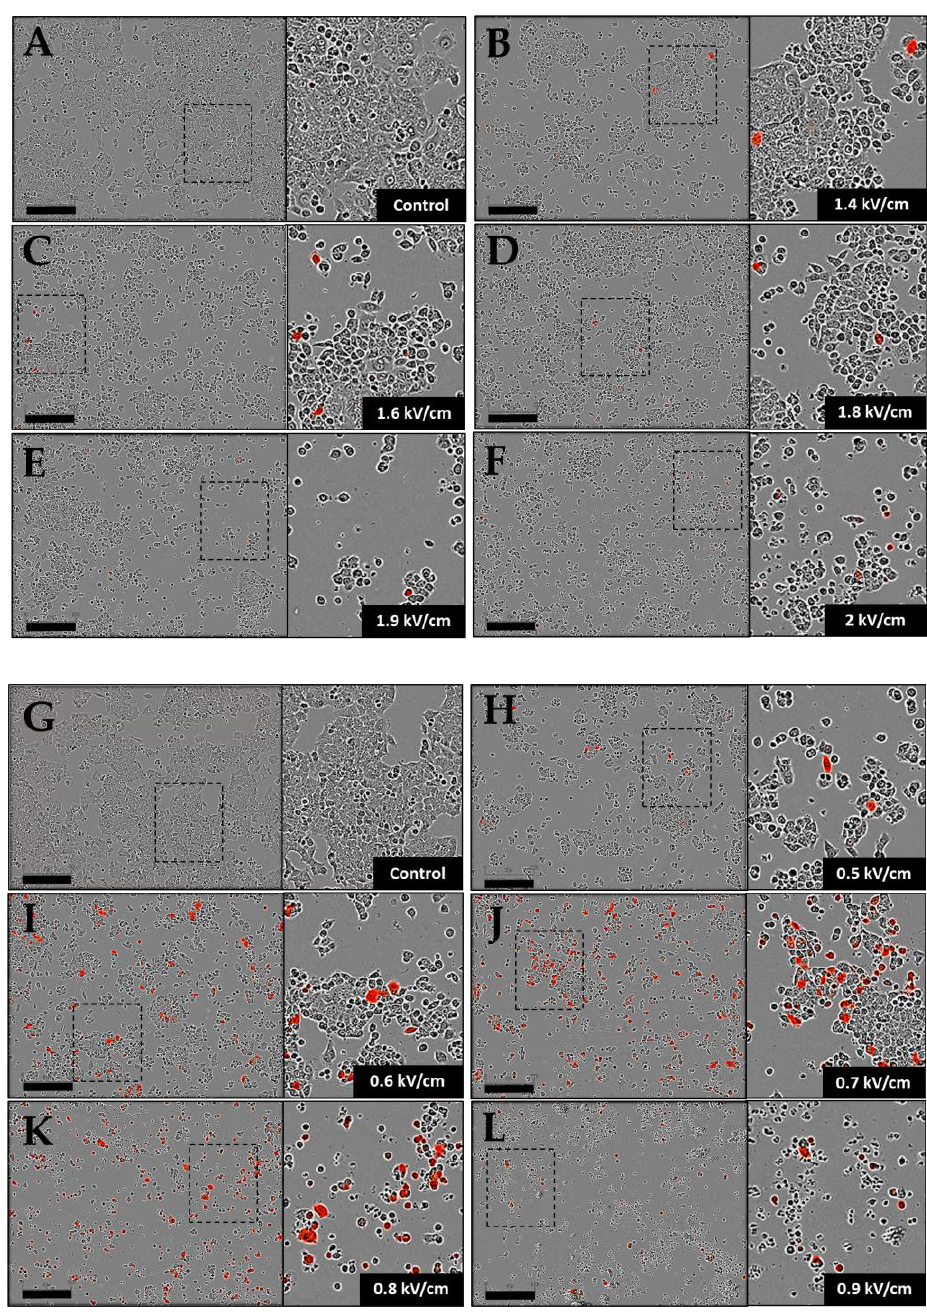
Figure 3. Representative bright field and fluorescent micrographs of HCT-116 cells, observed 24 h after pulsation. Cells were incubated with 40 µg/mL plasmid-encoding tdTomato, and ECT pulse parameters (8 pulses of 100 µs at 1 Hz with variables field intensity (1.4 to 2 kV/cm)) and GET pulse parameters (10 pulses of 5 ms at 1 Hz with variables field intensity (0.5 to 0.9 kV/cm)) were applied. ( A , G ) Control; ( B – F ) ECT pulse parameters and ( H – L ) GET pulse parameters. Cells expressing tdTomato emitted red fluorescence 24 h after pulsation. Scale bar = 300 µm. Zoom on the right corresponds to the rectangle in the entire image.